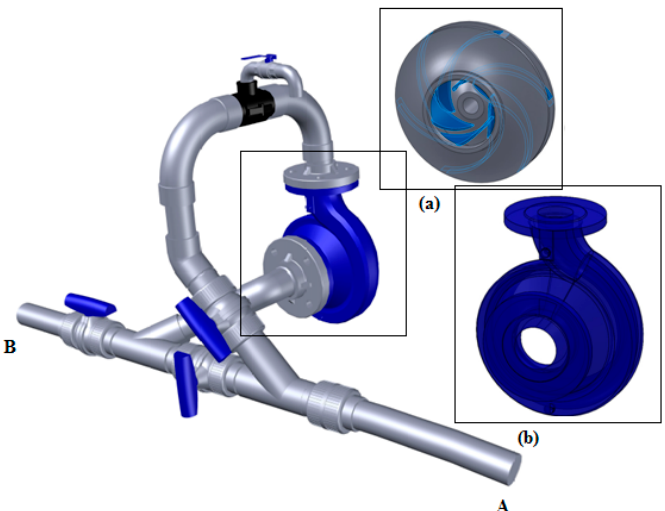
Figure 4. Geometric model for computational fluid dynamics (CFD) analyses: ( a ) pump as turbine (PAT) impeller; ( b ) PAT volute.